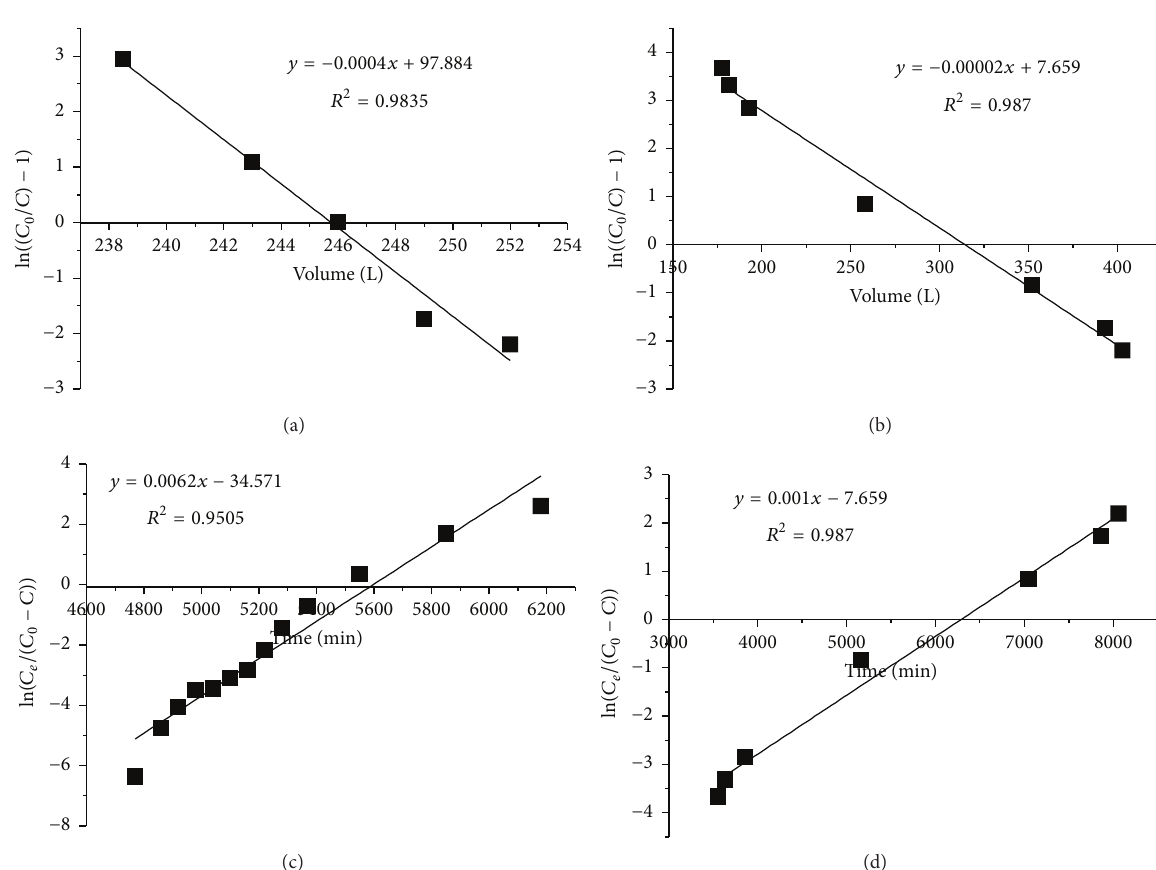
Figure 7: Plots of linearized kinetic approach results for the adsorption of (a) HCl and (b) VCM using Thomas model; (c) HCl and (d) VCM using Yoon-Nelson